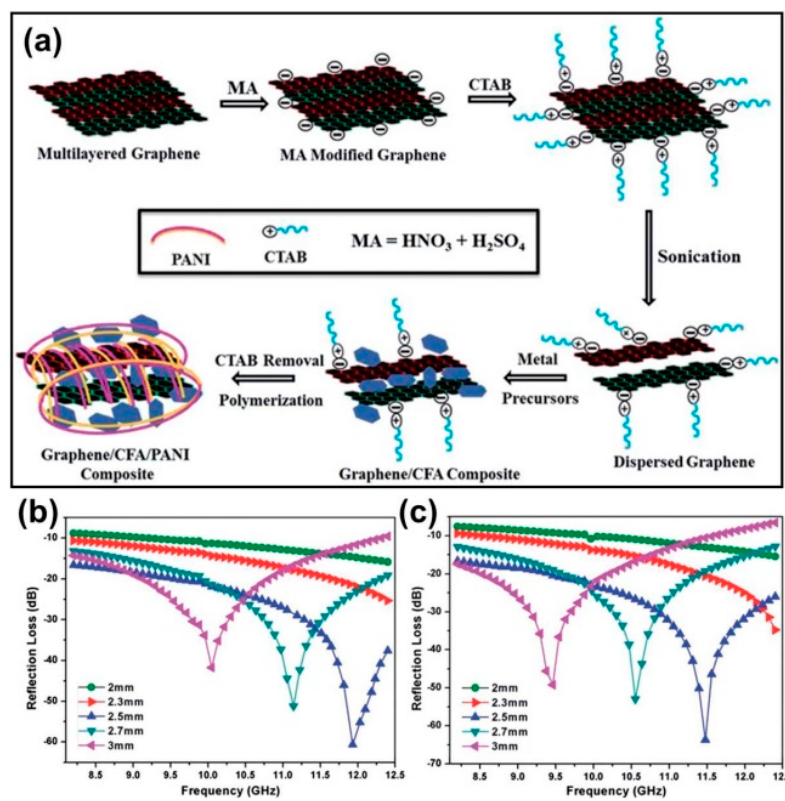
Figure 13. ( a ) Schematic representation of the preparation of the nanocomposites, CTAB: cetyltrimethylammonium bromide; ( b ) Reflection loss vs. frequency plots of graphene/CFA (CuFe 10 Al 2 O 19 ) and ( c ) graphene/CFA/PANI. Reprinted with permission from Reference [160].